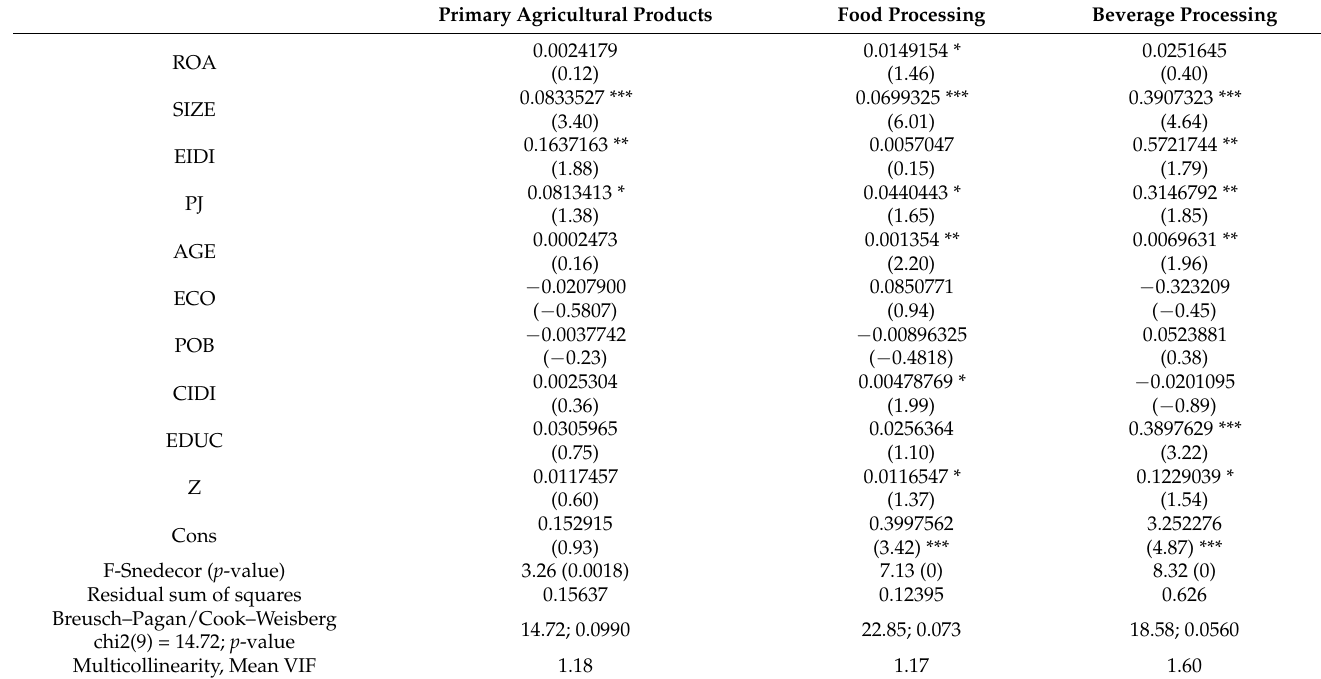
Table 6. Estimation